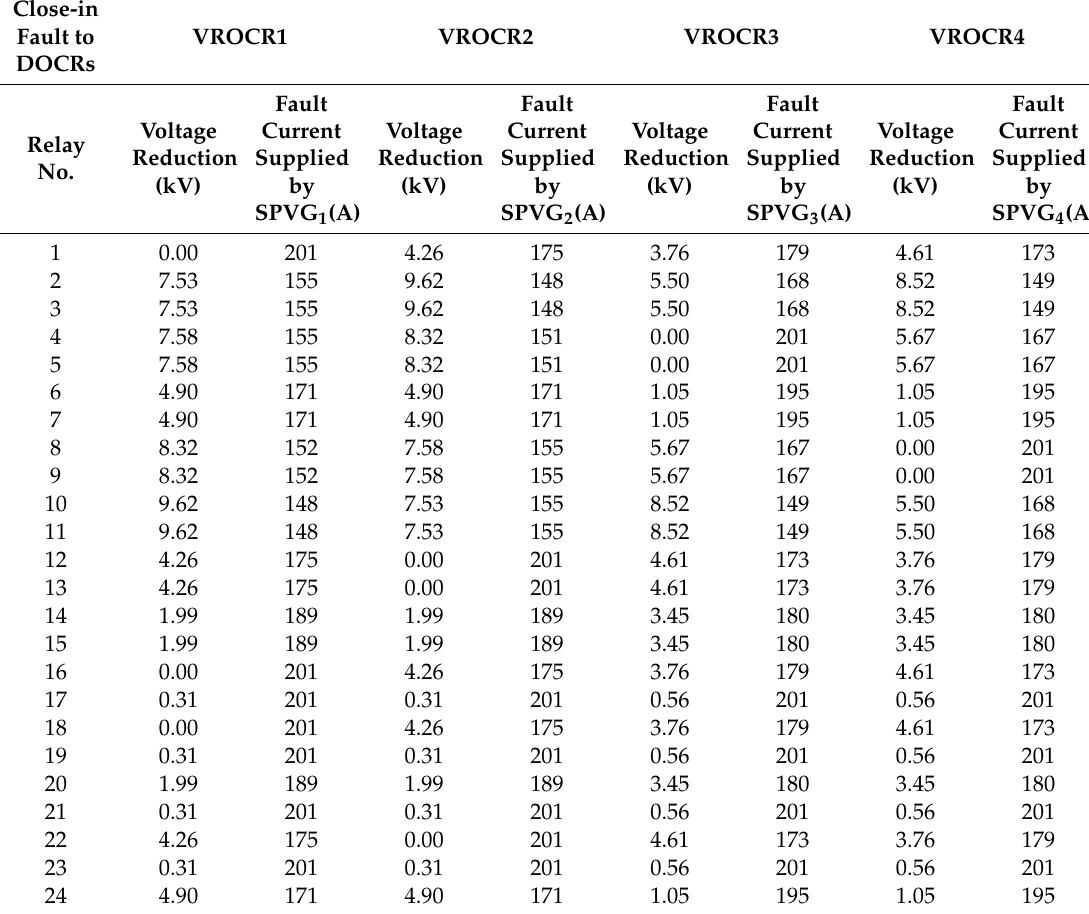
Table 7. Measured quantities by VROCRs for the close-in fault to each DOCR of the 9-bus network. Close-in Fault to DOCRs